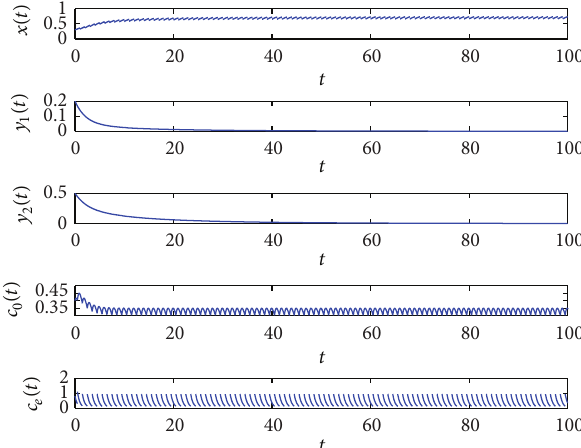
Figure 3: Time series of system (2) with parameters 𝛽 = 0.9 , 𝐾 = 0.8 , 𝑞 = 0.8 , 𝑑 = 0.4 , 𝜏 = 0.5 , 𝜆 = 0.8 , 𝛾 = 0.3 , 𝑏 = 0.8 , 𝑘 = = 0.2 , 𝑓 = 0.1 , 𝛿 = 0.1 , 𝛼 = 0.2 , ℎ = 2 , 𝑔 = 0.2 , 𝑚 = 0.5 , 𝑓 2 1 0.4 , and 𝑇 = 1 .